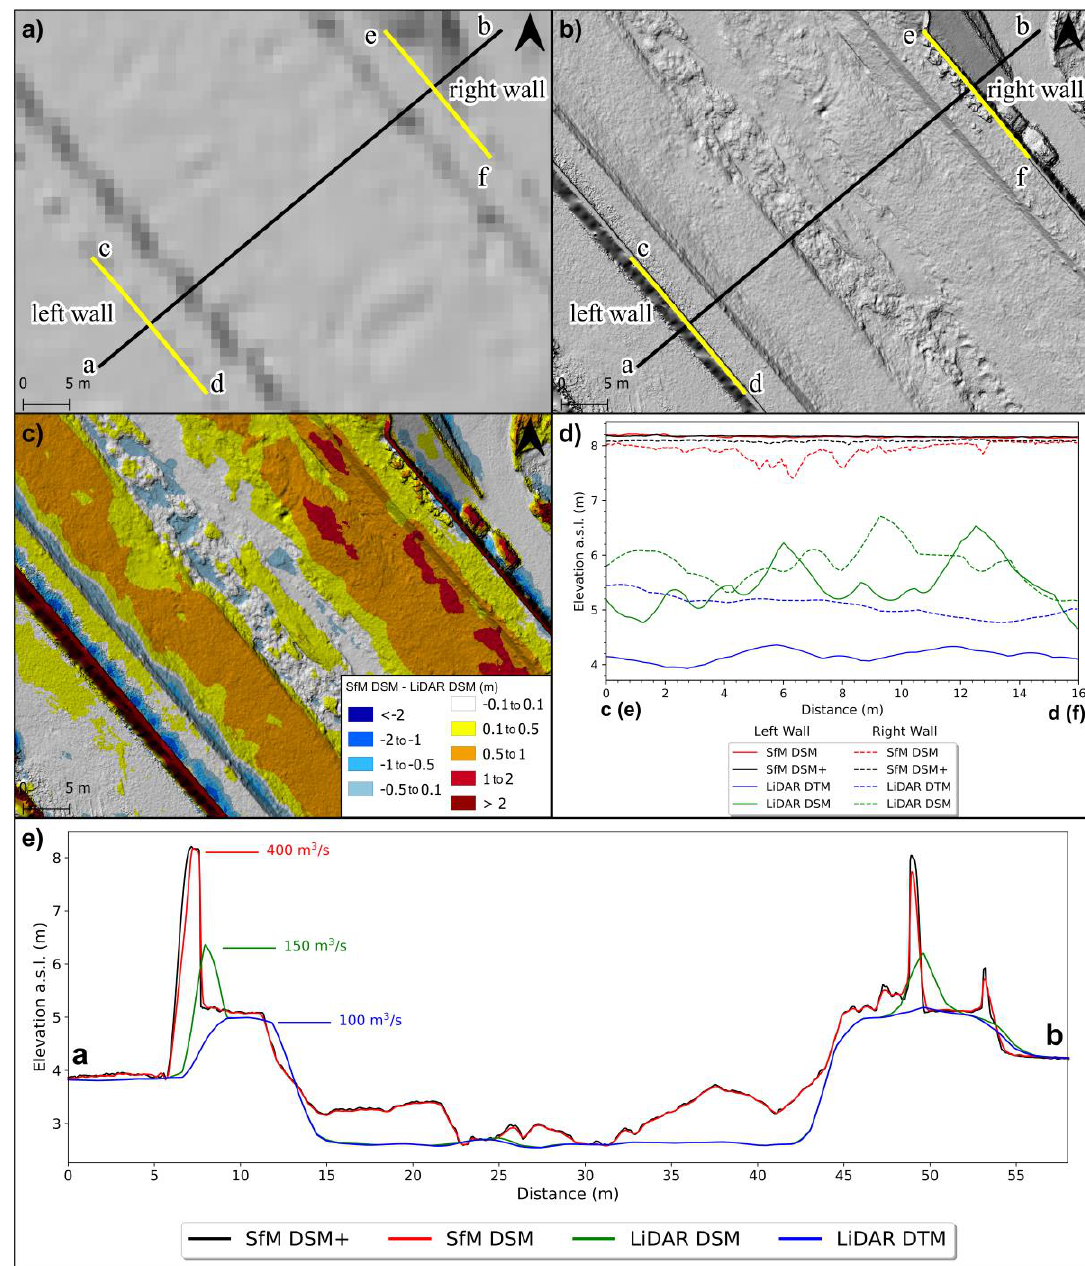
Figure 6. DEM analysis of relevant hydraulic features. ( a , b ) Hillshaded maps of the 1-m LiDAR DTM and SfM DSM, respectively. ( c ) Difference between SfM DSM and LiDAR DSM. ( d ) Longitudinal profiles along the embankment walls (yellow lines in frames a and b). ( e ) Profiles of the river cross section (black lines in frame a and b). Flow rate values show the maximum flow rate for the different DEMs according to FLO-2D simulations .